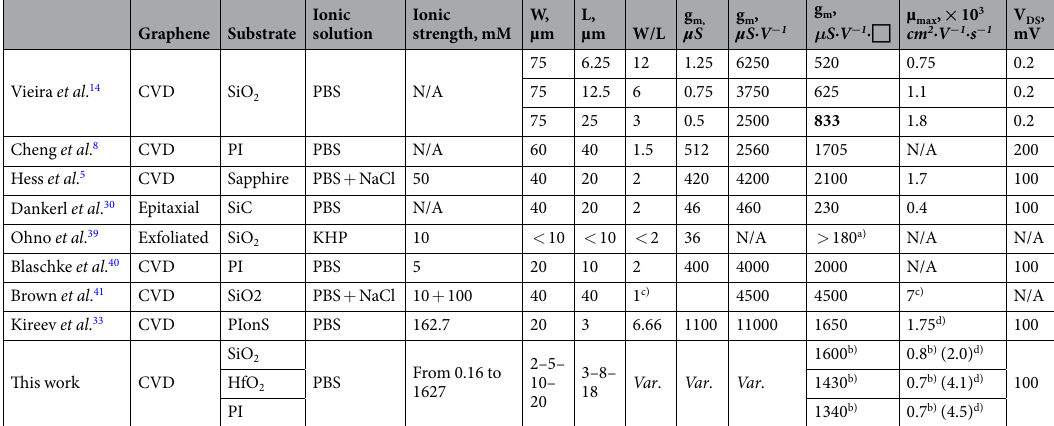
The last two important parameters for characterisation of the GFETs are the contact resistance, R C , and transfer length, L T . The transmission line measurement technique (TLMT) has been used to determine the parameters 38 . Details of the calculations are given in the Supplementary Information. We analysed the difference in the contact resistance for wafer Si-I (top contacted) and Si-II (double contacted) and the results can be seen in Supplementary Fig. S7. The mean value of both wafers’ sheet resistances are: R S, Si-I = 1550 ± 820 Ω and R S, Si-II = 1210 ± 1040 Ω. Clearly double side contacting reduces the contact resistance and therefore the overall sheet resistance of the GFETs. The computed transfer length for the wafers are: L T, Si-I = 8.5 ± 2.2 µ m and L T, Si-II = 3.6 ± 2.2 µ m. The trans- fer length is the path a charge carrier has to travel underneath the contact area before transfer to the feedline. Decreasing transfer length is important for further miniaturisation of the devices. This shows that the transfer length could be reduced by more than a factor of 2 using double contacted graphene. Table 1 is provided in order to directly compare the data from previously published works 5, 8, 14, 30, 33, 39–41 when the geometrical and environmental factors are taken into account. Interesting to see is that first of all just voltage normalised transconductance values can be misleading, and the values are extremely over/underestimated. When the values are further normalised per number of squares, the final performance shows a similar trend across publications. In order to show the applicability of the devices for bioelectronics applications, the devices were encapsulated and prepared for cell culture (see Supplementary Information). The devices were later measured at the custom-built multi-channel measurement set-up, the principle of which is schematically shown in Fig. 6a. The measurement routine consists of two steps. Firstly, calibration is done by applying a sine signal with a certain amplitude, V in , to the gate electrode, while source-drain signal amplitude, V out , is monitored and the overall amplification factor = A V V / is calculated. Next, in the recording/time series step, the V DS is simply meas- V out in ured, and the changes ( ∆ V DS ) are transformed into ∆ V GS by dividing by A V (see Fig. 6a). Every further presented time series data shows the actual gate potential fluctuations ( ∆ V GS ). Afterwards, an embryonic heart tissue is placed on the chip’s surface (see Fig. 6b). A Ag/AgCl pellet electrode is placed as close to the tissue as possible in order to provide a stable potential through a small amount of ionic solution (supplementary medium). The time trace recording from one of the channels (GFETs) is presented in Fig. 6c showing repetitive spikes up to 7 mV with a beat rate of 30–40 beats per minute (bpm). When the action potentials (APs) from one channel are extracted and averaged, they result in a very distinct shape with visible Q, R, S and slight T regions of the electrocardiogram (Fig. 6d). The heart tissue measurements show an excellent applicability of the GFETs for ex vivo bioelectronics. The overall signal-to-noise ratio (SNR) of the measurements is up to 17, while considering the noise as twice the median absolute distribution (MAD, see Supplementary Information for discussion). Cardiomyocyte-like cells (HL-1 cell line) are further cultured on the chips’ surface (see Fig. 6e). A typical time trace recording from a GFET with HL-1 action potentials is shown in Fig. 6f. The cells are beating (produc- ing repetitive APs that propagate through the whole cellular layer) with a rate over 25 bpm and an amplitude of 1.2 ± 0.2 mV. Considering the 2·MAD noise level of 200 µ V, the overall SNR is 6 ± 1, which is in the same sensitiv- ity range as reported previously 40, 42 . The shape of the APs is shown in Fig. 5g, where over 115 consecutive spikes are averaged and the average AP is shown in blue. The shape of the action potential, in agreement with previous works, represents a very good sealing between the cell and the transistor 43, 44 . Further, cortical neurons were cultured on top of the chips (details are given in Methods) with an approx- imate density of 1500 cells per mm 2 . The neuronal network was cultured for at least 14 days in vitro (DIV14) until mature, when the cultured neurons produce spontaneous APs that can propagate through the network. As expected, the extracellular neuronal APs are one or two orders of magnitude smaller than those of heart tissue 45 . Nevertheless, we were able to record the APs and even bursting activity of neuronal networks with the GFETs (Fig. 6h). More time trace recordings (including one after killing the cells) and live-dead fluorescence images can 7 Scientific REPORTS | 7: 6658 | DOI:10.1038/s41598-017-06906-5